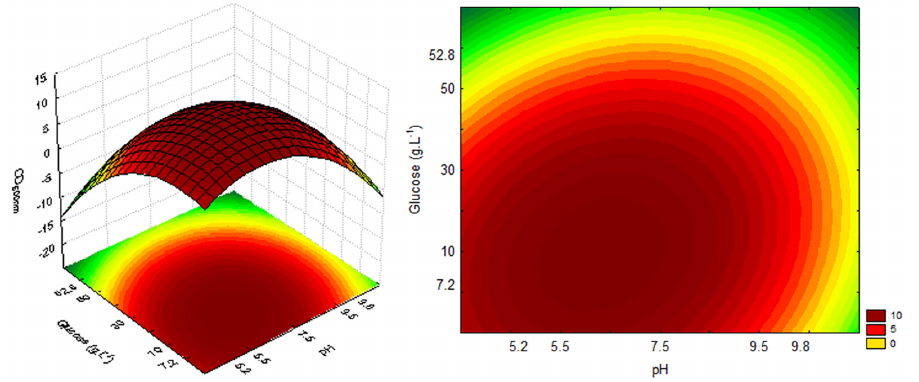
Fig 5. Response and contour surfacesas a function of glucose concentration and pH for OD 600nm